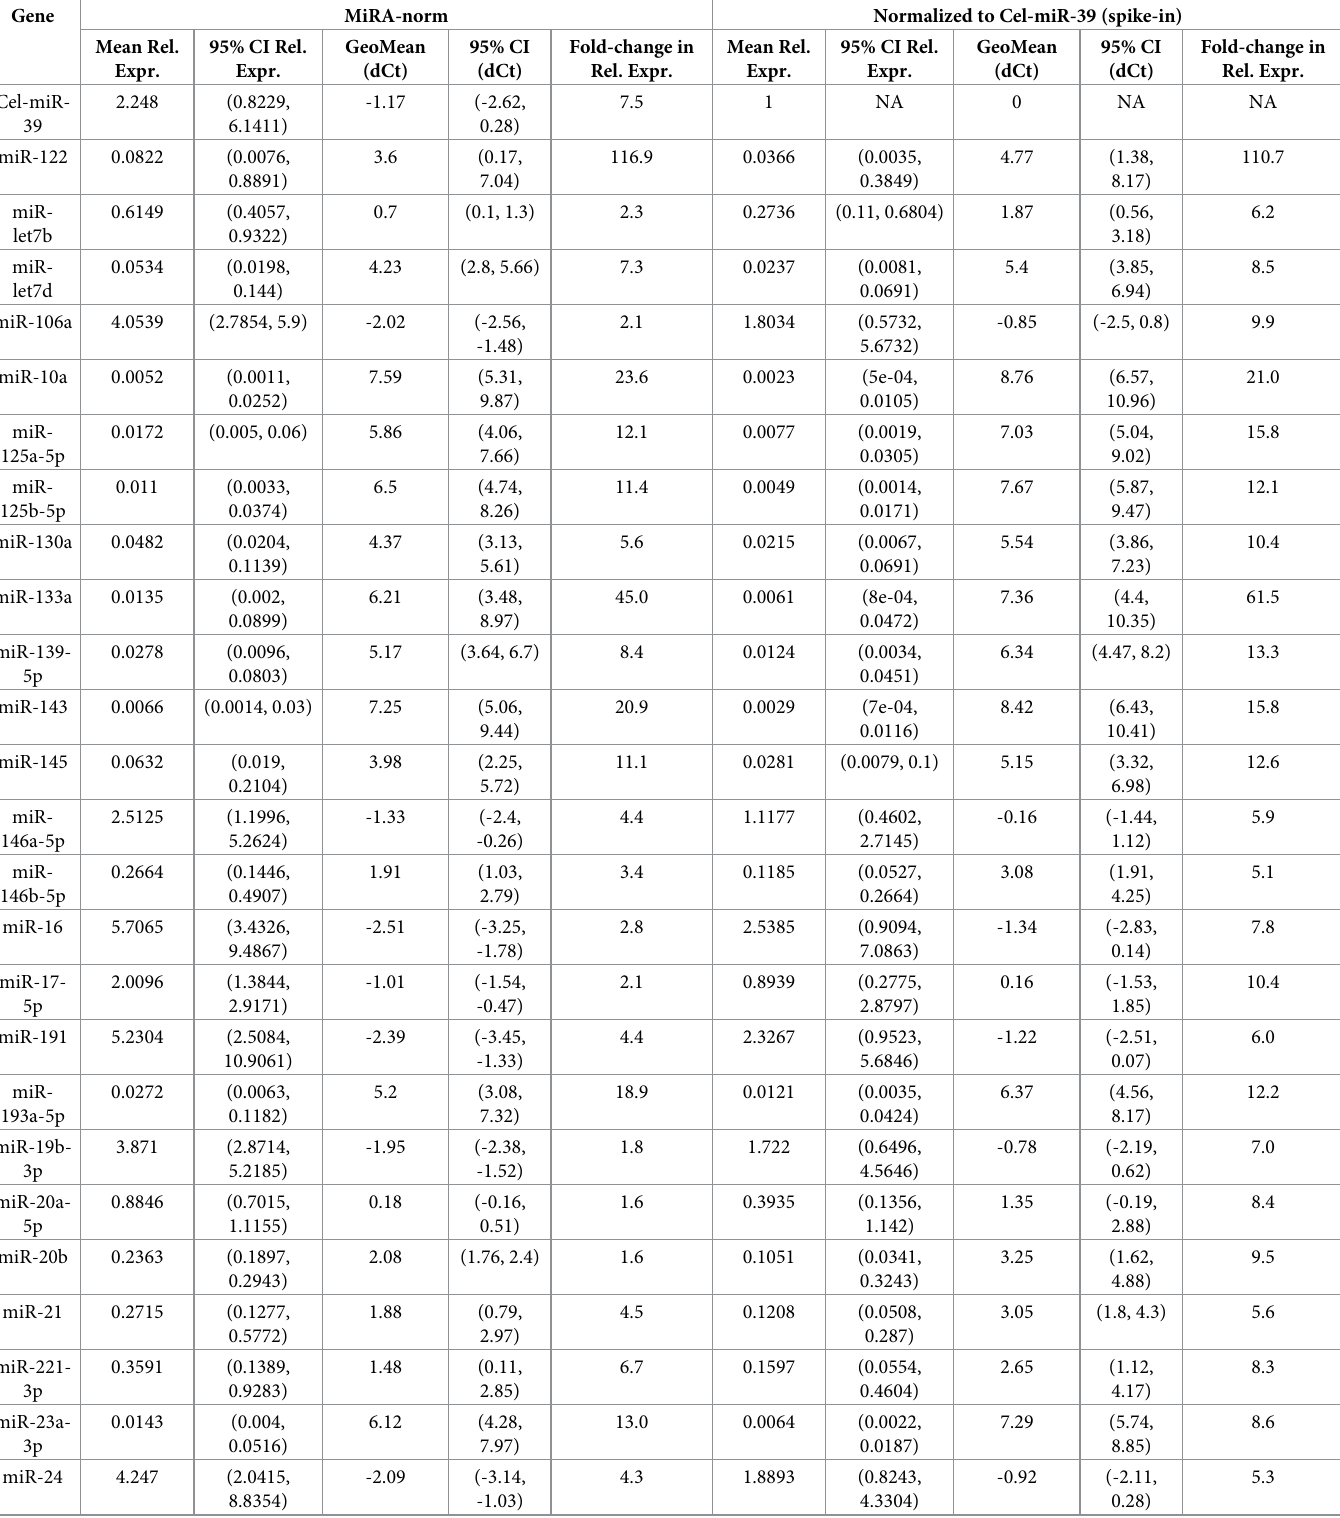
Table 2. The 95% confidence reference ranges of other 38 abundant miRNAs in relation to miR-122 in serum from healthy volunteers. Gene MiRA-norm Normalized to Cel-miR-39 (spike-in) Mean Rel. 95% CI Rel. GeoMean 95% CI Fold-change in Mean Rel. 95% CI Rel. GeoMean 95% CI Fold-change in Expr. Expr. (dCt) (dCt) Rel. Expr. Expr. Expr. (dCt) (dCt) Rel.